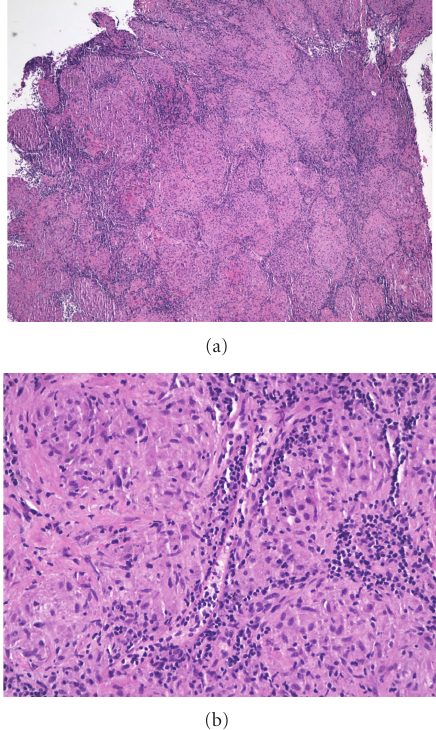
Figure 2: (a) Lymph node biopsy (low power). (b) Lymph node biopsy (high power).